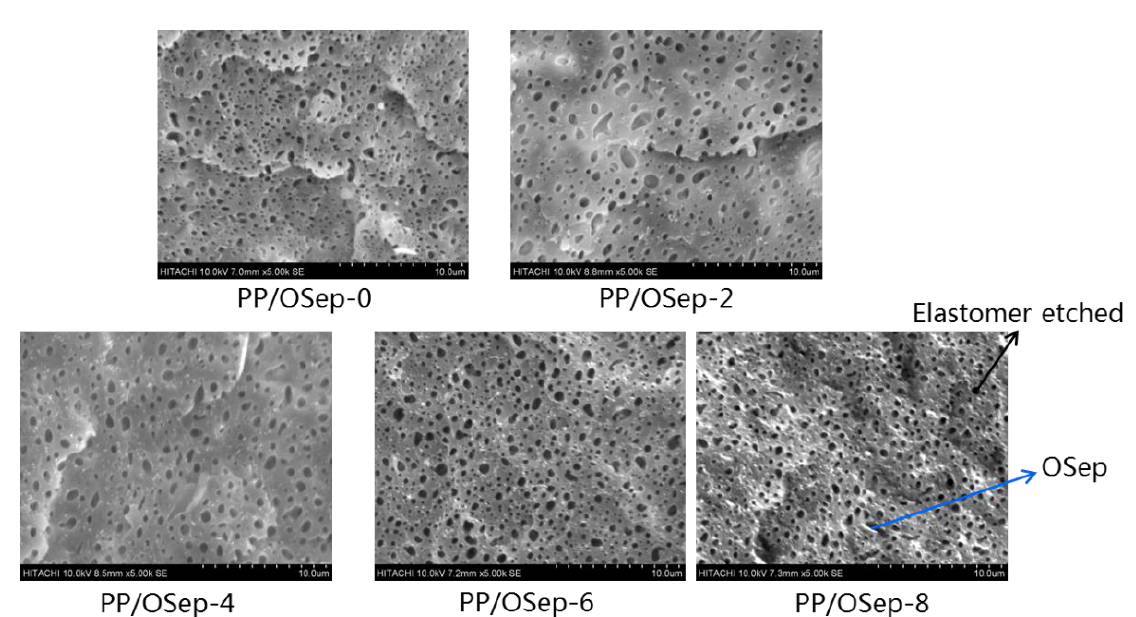
Figure 4. Morphology of PP/Osep nanocomposites with various Osep loadings.